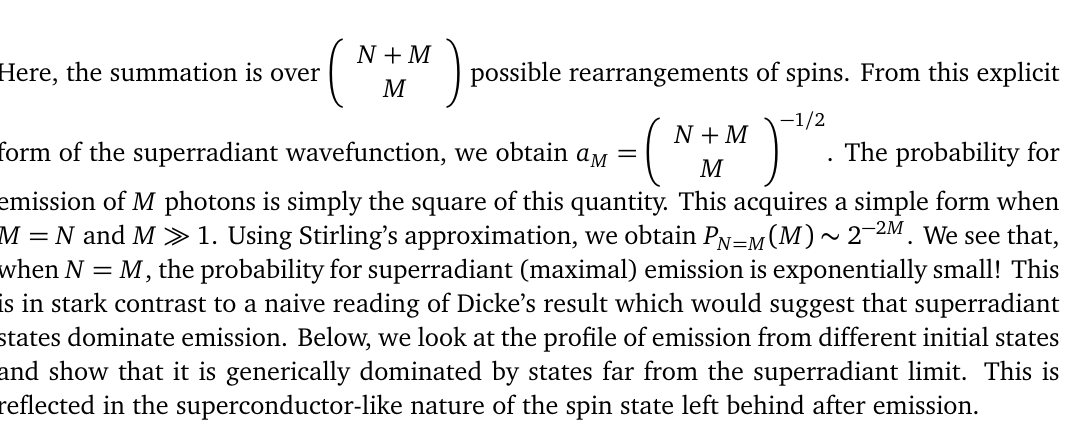
Figure 5: Probability distribution of number of photons emitted, P ( γ ) vs. γ . This distribution is shown for different α , which denotes the imbalance in the initial state. The α corresponding to each curve is